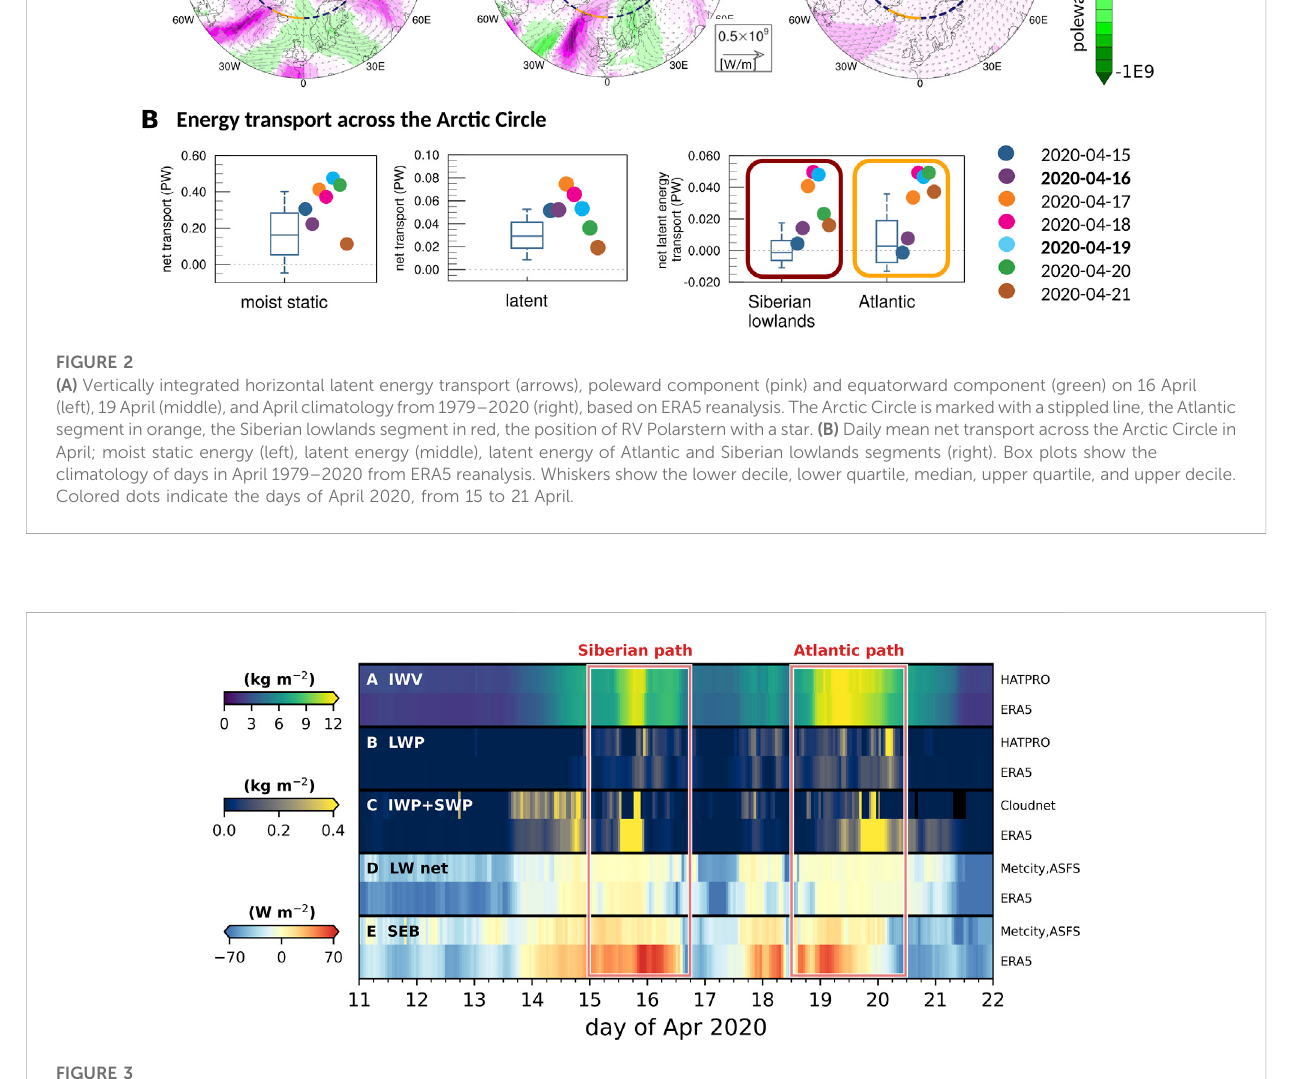
Comparison between observed and ERA5-extracted cloud and moisture parameters at RV Polarstern during mid-April 2020. The red boxes denote the peak time periods of the two subsequent episodes of the WAI, with their Siberian and Atlantic pathways. Shown are the hourly means of (A) IWV from HATPRO, (B) LWP from HATPRO, (C) IWP+SWP based on Cloudnet observations, (D) longwave net radiation (LW net ) from measurements at Met City and autonomousAtmosphericSurface FluxStations (ASFS), (E) SEB,derived atMetCityandASFS. ForLW net andtheSEB,downward fl uxes arede fi nedas positive. Included in each graph is also the ERA5 reference. Data sources are indicated on the right